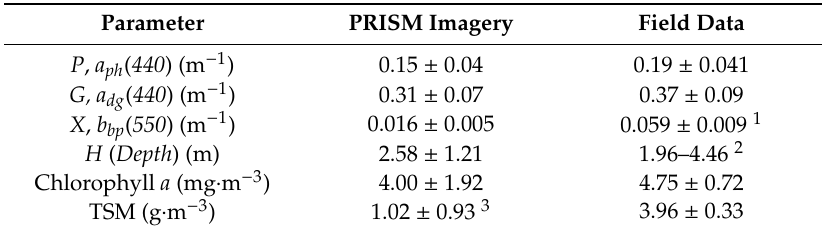
Table 3. Comparison of HOPE retrievals of water column optical properties and bathymetry of the Vierra seagrass bed with concurrent field data.